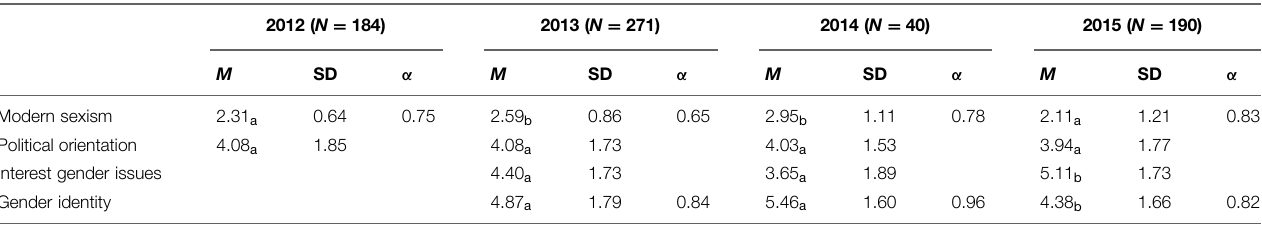
TABLE 2 | Means and standard deviations for included variables for each year,